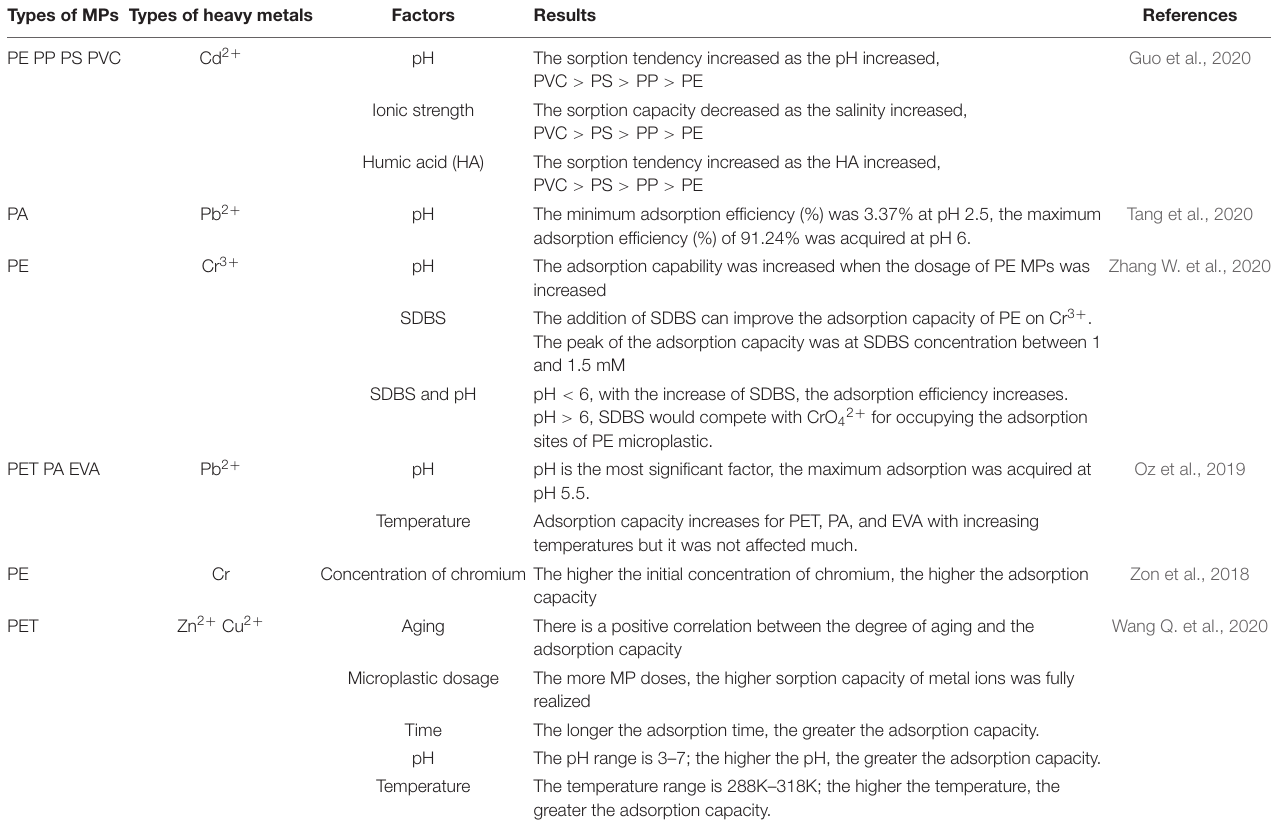
TABLE 1 | Research on the characteristics of interaction between MPs and heavy metals. Types of MPs Types of heavy metals Factors